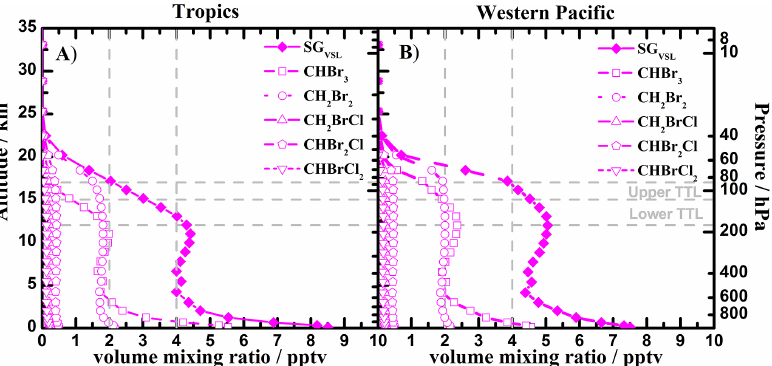
Figure 2. Vertical profile abundances of the five VSL bromocarbons considered in CAM-Chem for the tropical annual average (a) and the Western Pacific region (b) . All halocarbon abundances are multiplied by their respective atomicity in order to represent their contribution to Br y after photolysis or reaction with OH. The total organic SG VSL contribution is also shown by the filled